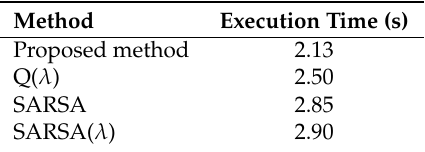
Table 4. Execution times for the